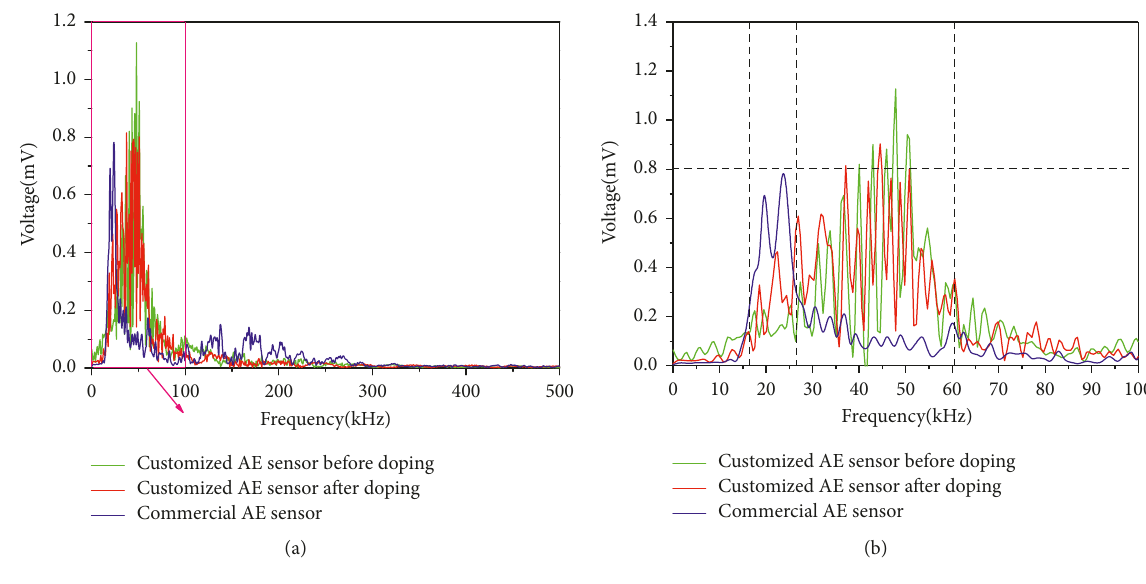
Figure 4: Frequency spectrum of acoustic emission